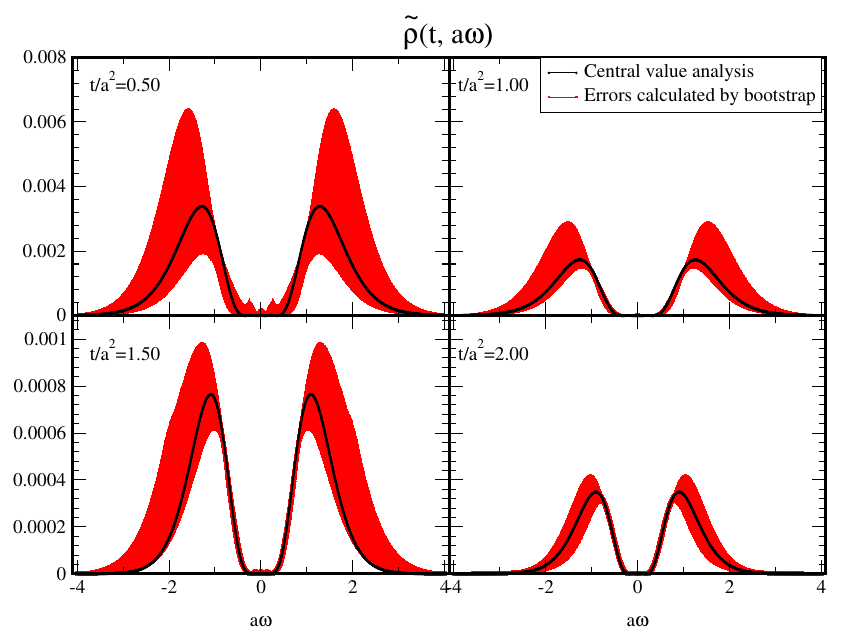
Figure 11 . The statistical error of the spectral function using the bootstrap